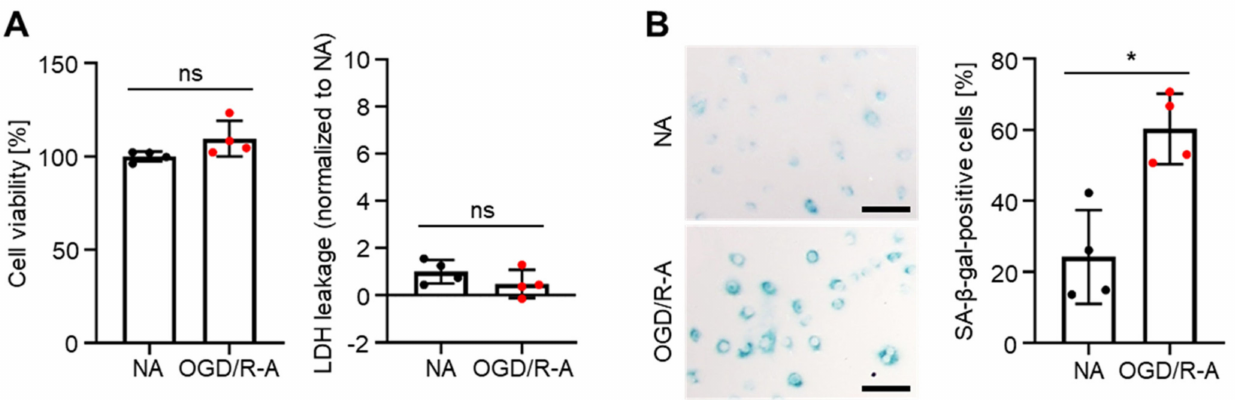
Figure 1. Rat astrocyte senescence induced in vitro by oxygen-glucose deprivation/reoxygenation (OGD/R). ( A ) Viability and death of normal astrocytes (NA) and OGD/R-injured astrocytes (OGD/R-A), as evaluated by 3-(4,5-dimethylthiazol-2- yl)-2,5-diphenyltetrazolium bromide (MTT) assay and lactate dehydrogenase (LDH) release assay, respectively. OGD/R injury showed no cytotoxicity to rat cortex astrocytes. ns = not significant. n = 4 per group. ( B ) Representative images and quantification of senescence-associated beta-galactosidase (SA- β -gal) staining (green) after 4 h of OGD/R injury. OGD/R injury induced senescence in rat cortex astrocytes. Scale bars, 100 µ m. n = 4 per group. ( A , B ) Data are presented as mean ± SD. * p < 0.05. Mann–Whitney test was used for statistical